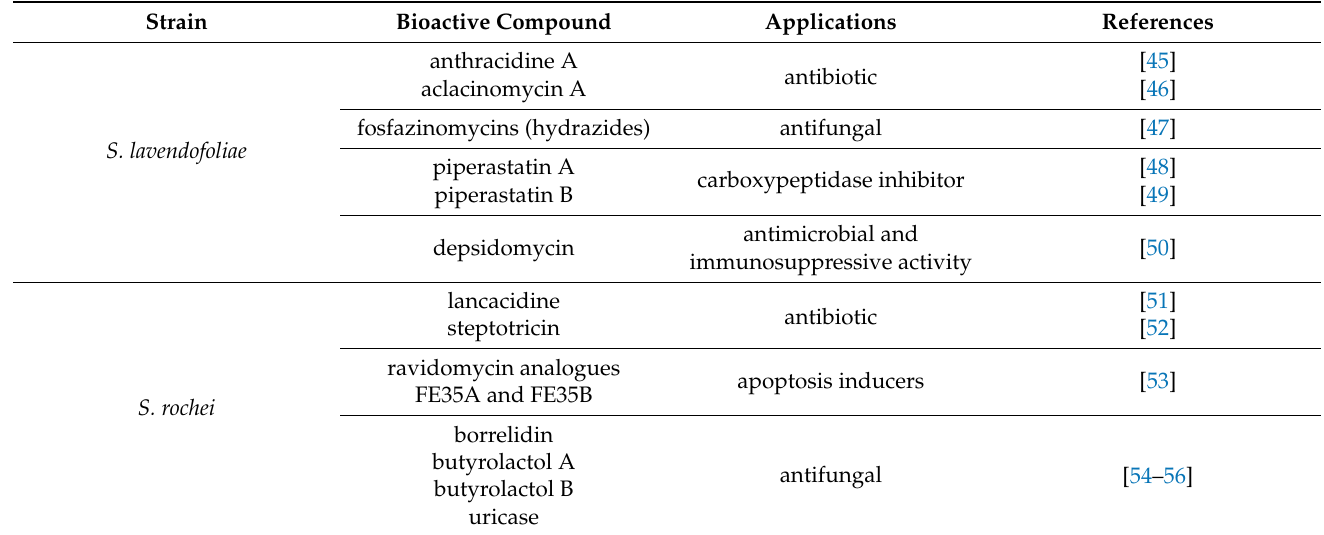
Table 3. Secondary metabolites with biological activity produced by S. lavendofoliae and S. rochei .